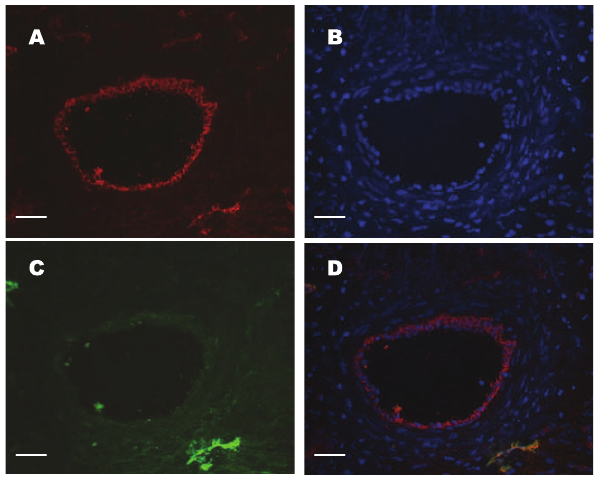
Figure 1. Blood and lymphatic identification in onchocercoma. Five-micrometer serial sections were stained with (A) CD31 or (C) Lyve- 1; (B) DAPI nuclear counterstaining. (D) Merging of A, B and C. Number of analysed nodules=5. Scale: A, B, C, D: bar=25 m